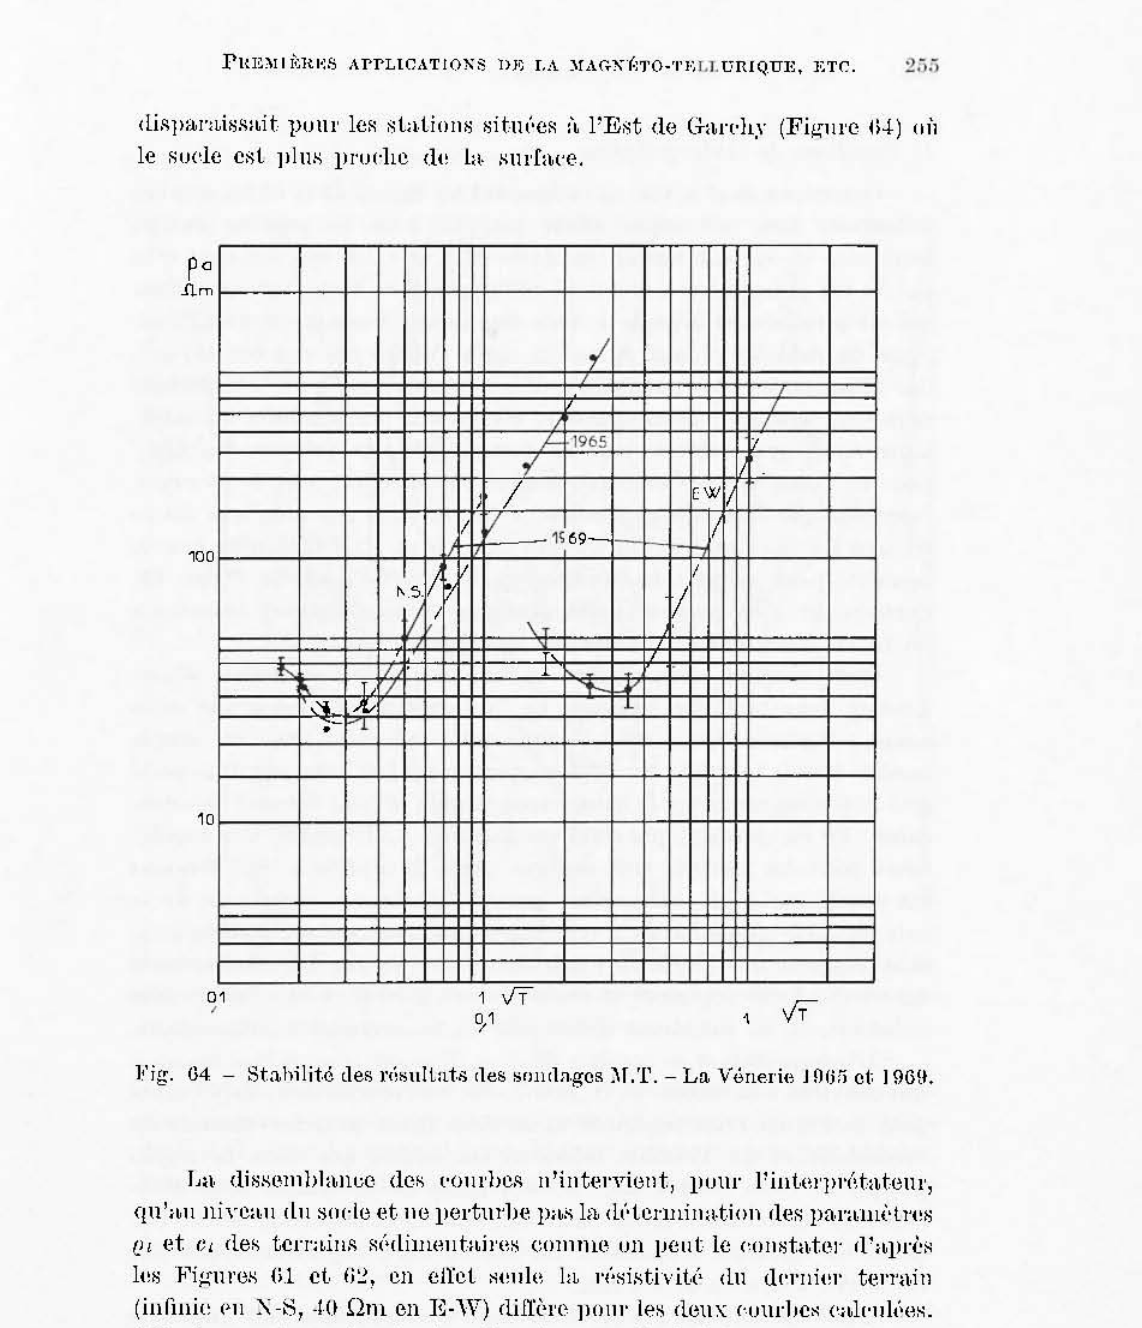
Fig. 04 - Stahi!it.é tles r(i~llllat.;; Iles SfJllllages )T.T. - Ln. Vunerie Jf)(j" et,